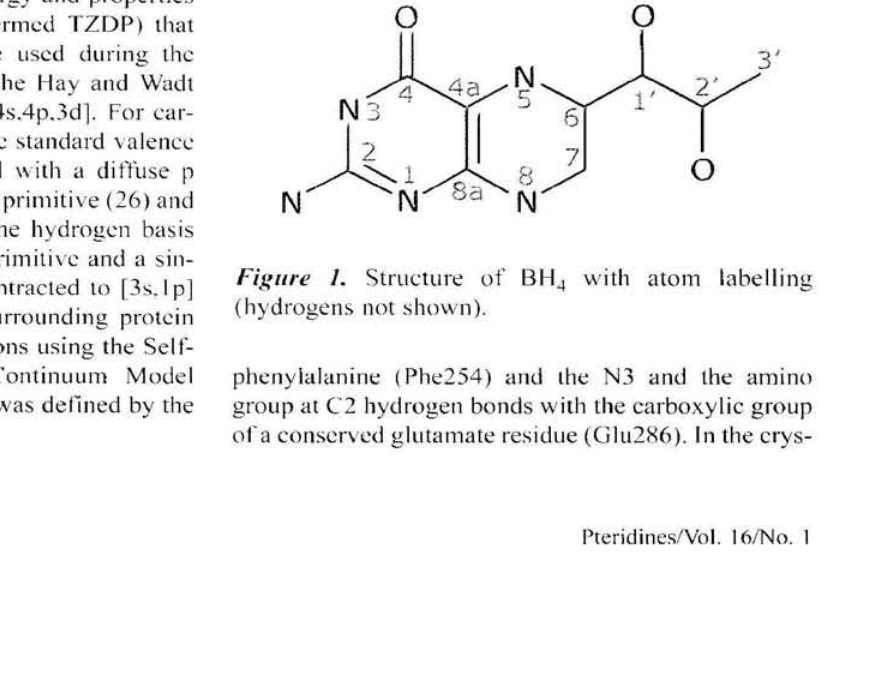
Pteridines/Vol. 16/No.